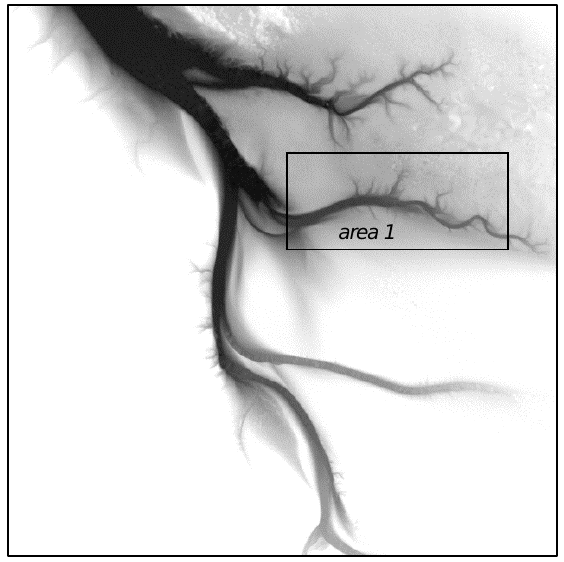
Figure 6: DTM of the test site in which the tidal channels have a low height. Some analyses are performed only for the outlined section area 1